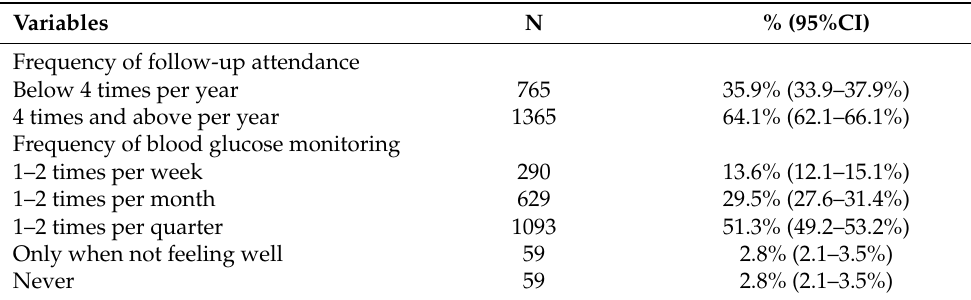
Table 2. Frequency of follow-up attendance and blood glucose monitoring among T2DM patients at moderate to high CV risk.